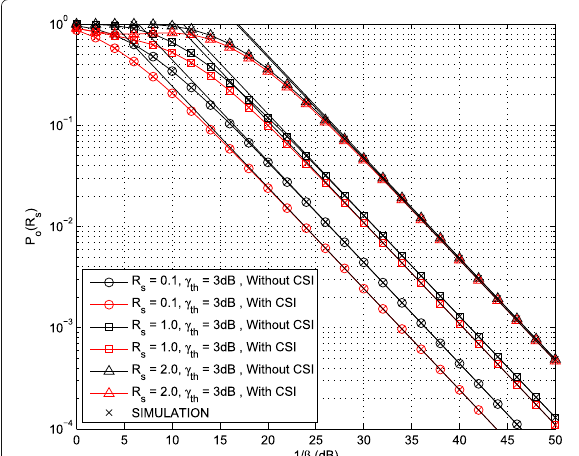
Fig. 2 Comparison of outage probability with 1 /β under no direct link scenario both with and without CSI for R s = 0.1,1.0, and 2.0; and = 3 dB of single balanced relay system γ th